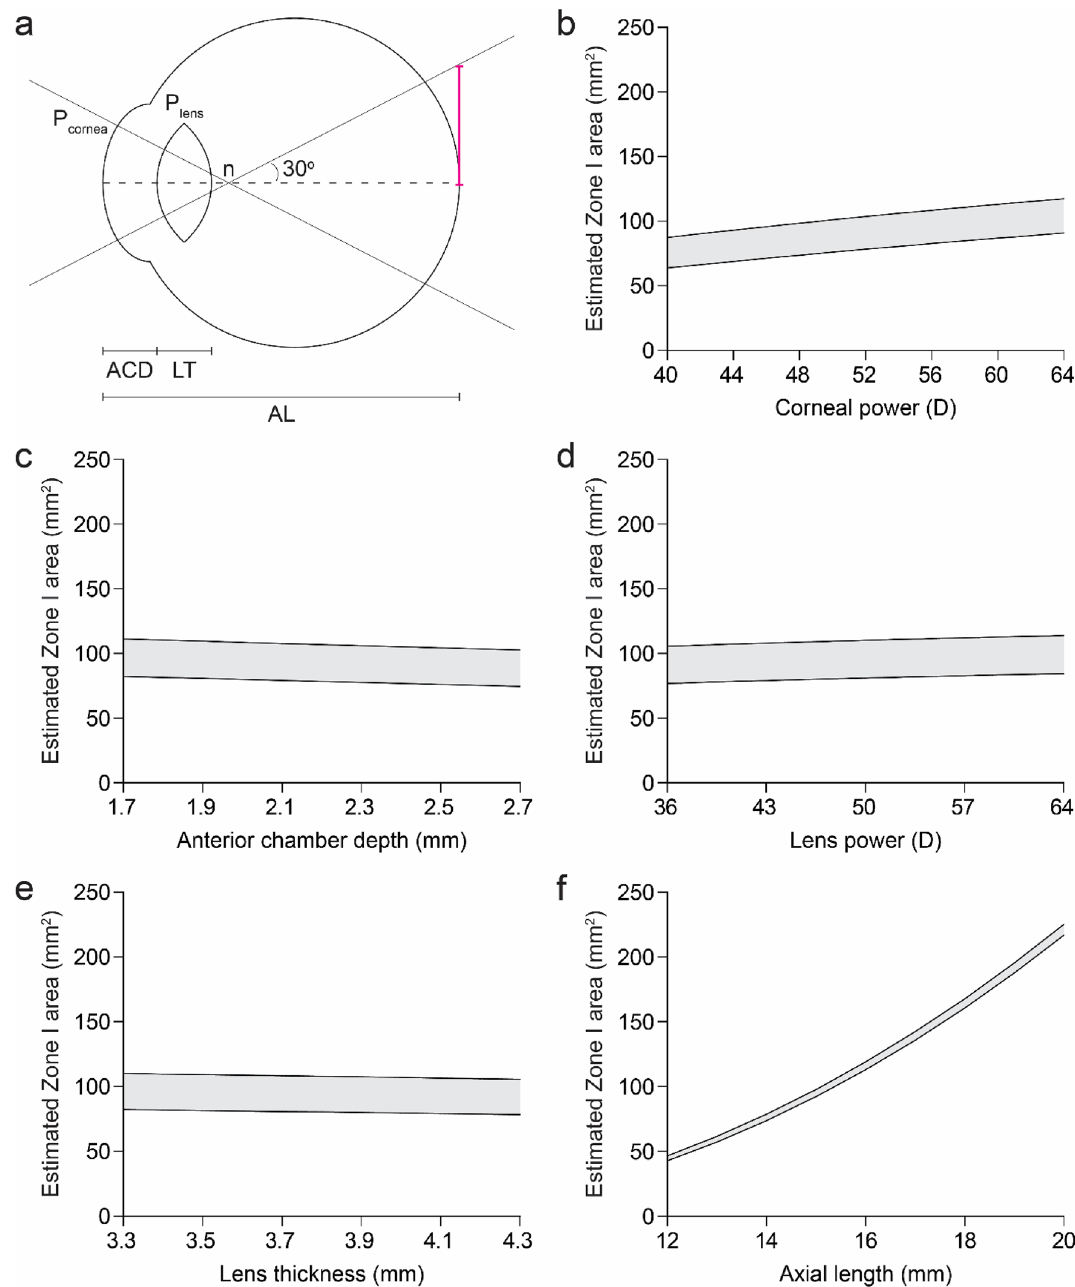
Figure 2. Zone I area is most sensitive to changes in axial length. ( a ) Ocular parameters used to estimate the absolute area of ICROP Zone I. After determining the position of the nodal point (n) based on P cornea , P lens , ACD, and LT, the radius (magenta) of the circle corresponding to Zone I was calculated as tan(30°) times the distance from the nodal point to the back of the eye. For further details, see Methods. ( b – f ) Range of estimated Zone I areas at PMA 31 weeks when modifying only corneal power (b), anterior chamber depth ( c ), lens power ( d ), lens thickness ( e ), or axial length ( f